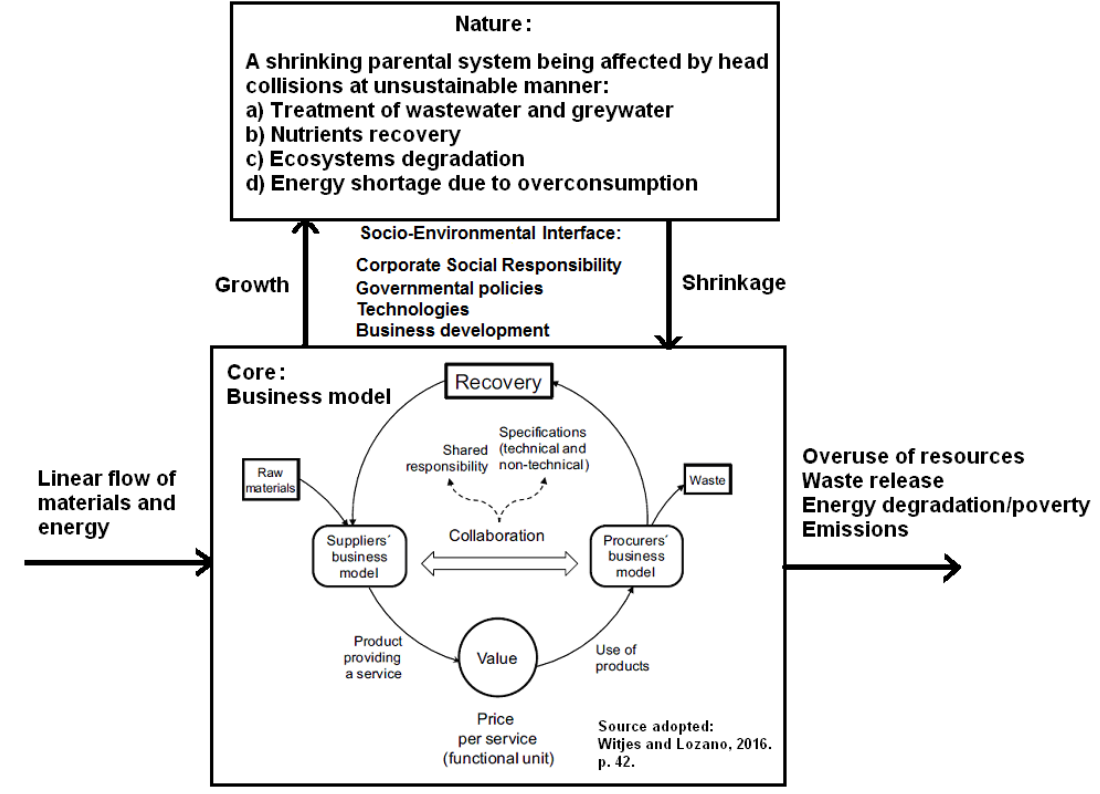
Figure 1. Diagrammatic representation of the linear flow of materials and energy in coordination to: a) the growing business modeling, b) the shrinking parental system, and c) the socio-environmental interface developed. Sources adapted: Korhonen et al. ([70], p. 38); Witjes and Lozano ([71], p. 42); Liu and Cote ([74], p. 7).